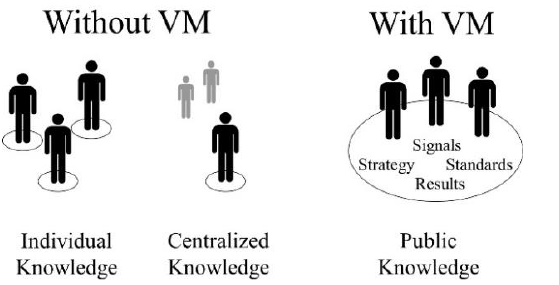
Figure 1. Visual Management (adapted from Jaca et al, 2014) Figure 2. Traditional forklift versus